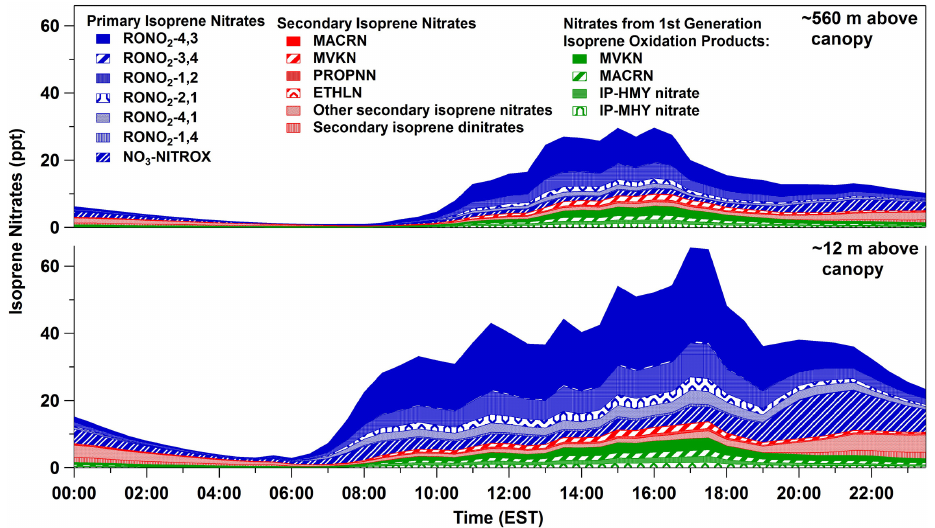
Fig. 7. Diurnal cycles of the modeled concentrations of isoprene nitrates at ∼ 12 and ∼ 560m above the forest canopy for the base isoprene production rate scenario. Structures of specific primary and secondary isoprene nitrates are shown in Tables 2 and 3.